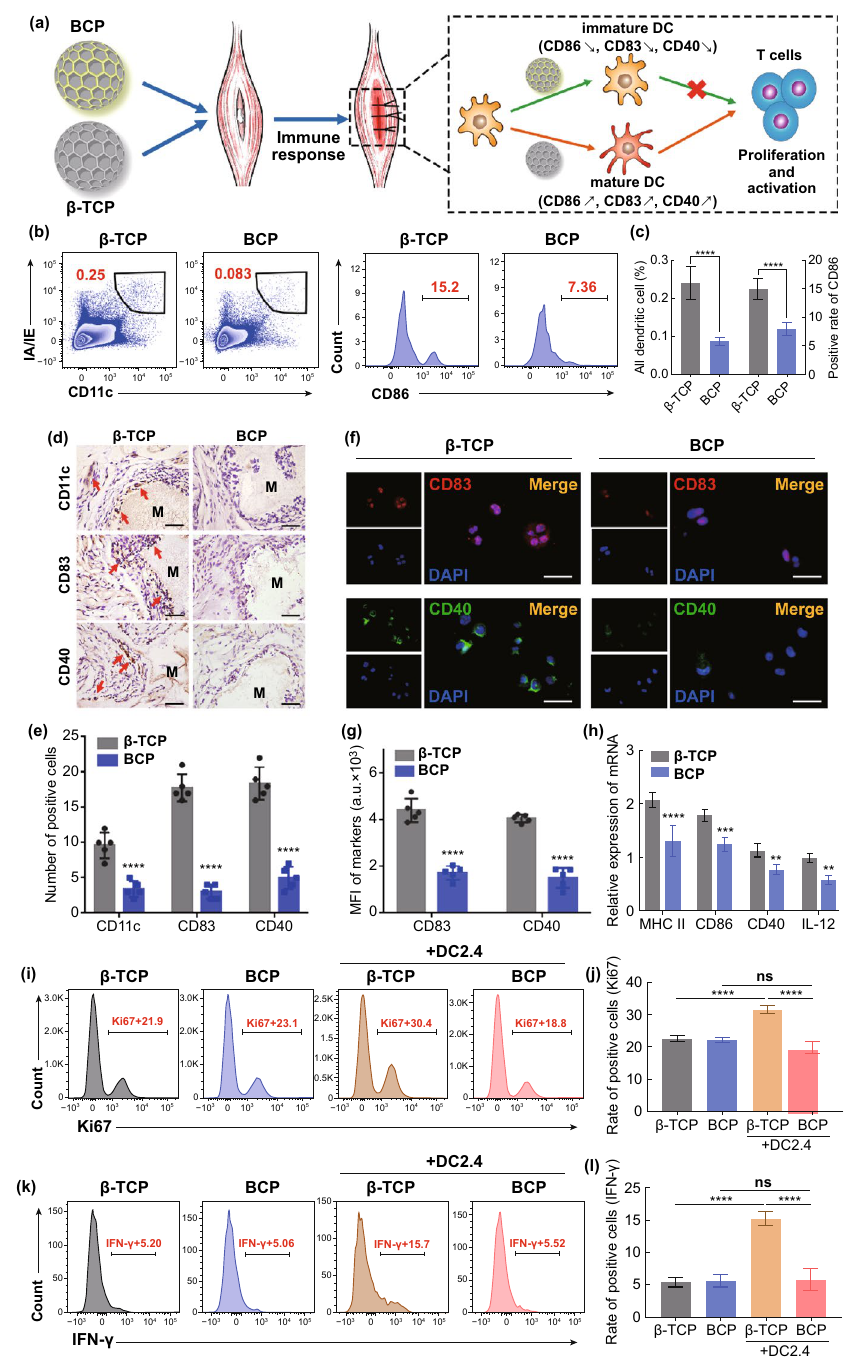
Fig. 3 a Schematic diagram of biomaterial-mediated DC maturation and T cell activation. b FACS of all DCs (CD11c + , IA/IE +) and mature DCs (CD11c + , IA/IE + , CD86 +) recruitment at 2 weeks after biomaterials implantation in vivo. c Semiquantification of gating strategy cells in (B). n = 6, **** P < 0.0001. d IHC staining of CD11c—DC marker and CD83/CD40—mature DC markers at 4 weeks after biomaterials implantation in vivo. Red arrow, positive cell. Scale bar = 100 μm. M, material. e Semiquantification of positively stained cells in ( d ). n = 5, **** P < 0.0001. f Immunofluorescent (IF) staining of CD83 (red), CD40 (green) and nuclei (blue) after DCs seeded on the BCP or β -TCP for 24 h. Scale bar = 5 μm. g Semiquantification of positively stained cells in ( f ). n = 5, **** P < 0.0001, ns: not significant. h Relative mRNA expressions of DC maturation genes (MHC II, CD86, CD40, IL-12). n = 3, ** P < 0.01, *** P < 0.001, **** P < 0.0001. i‑l FACS of T cell prolif- eration (Ki67 +) and activation (IFN-γ) and semiquantification of positive cell rate. n = 6, *** P < 0.001, **** P < 0.0001, ns: not